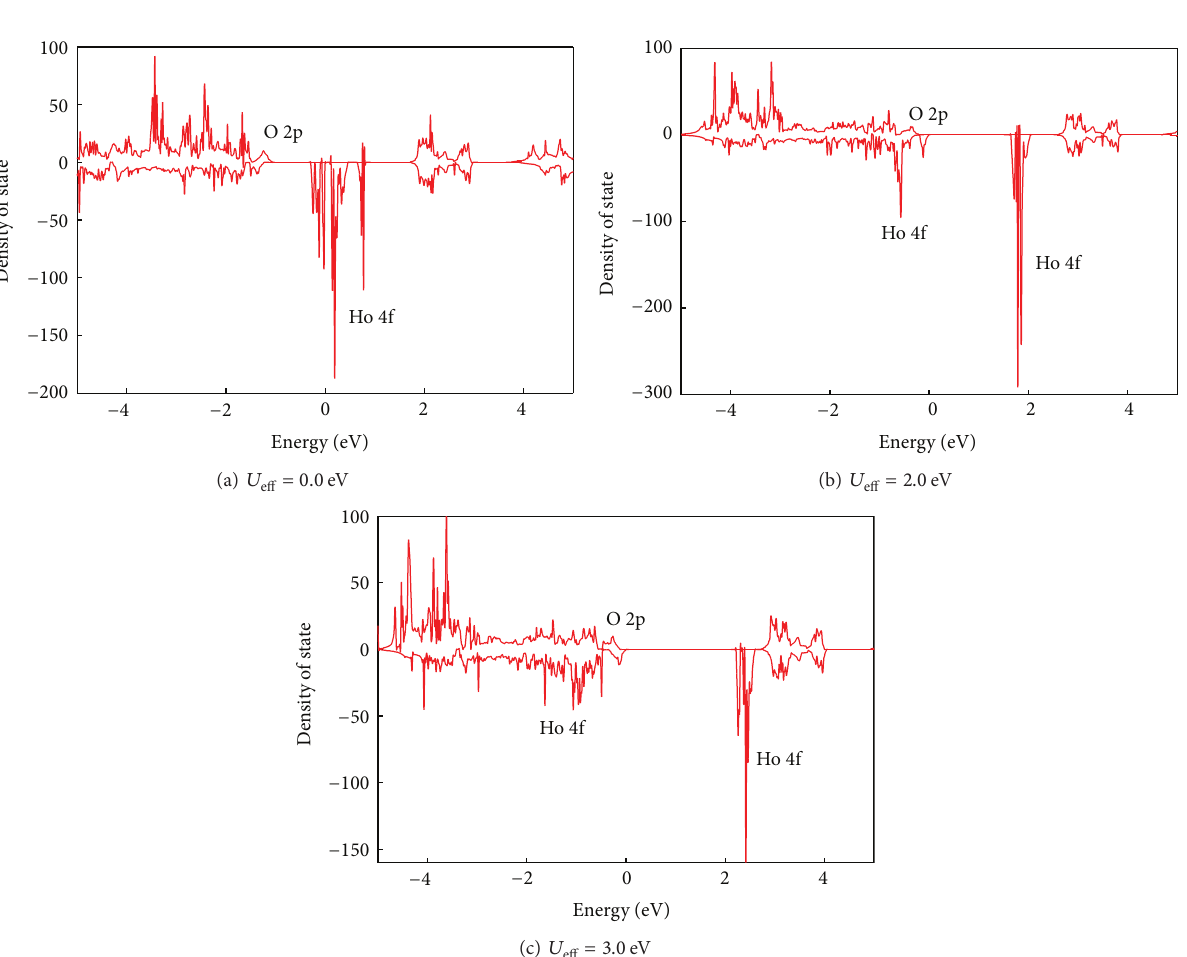
Figure 4: Total DOS distribution for Ho 2 Ti 2 O 7 . (a) 𝑈 the spin-up and spin-down channels,